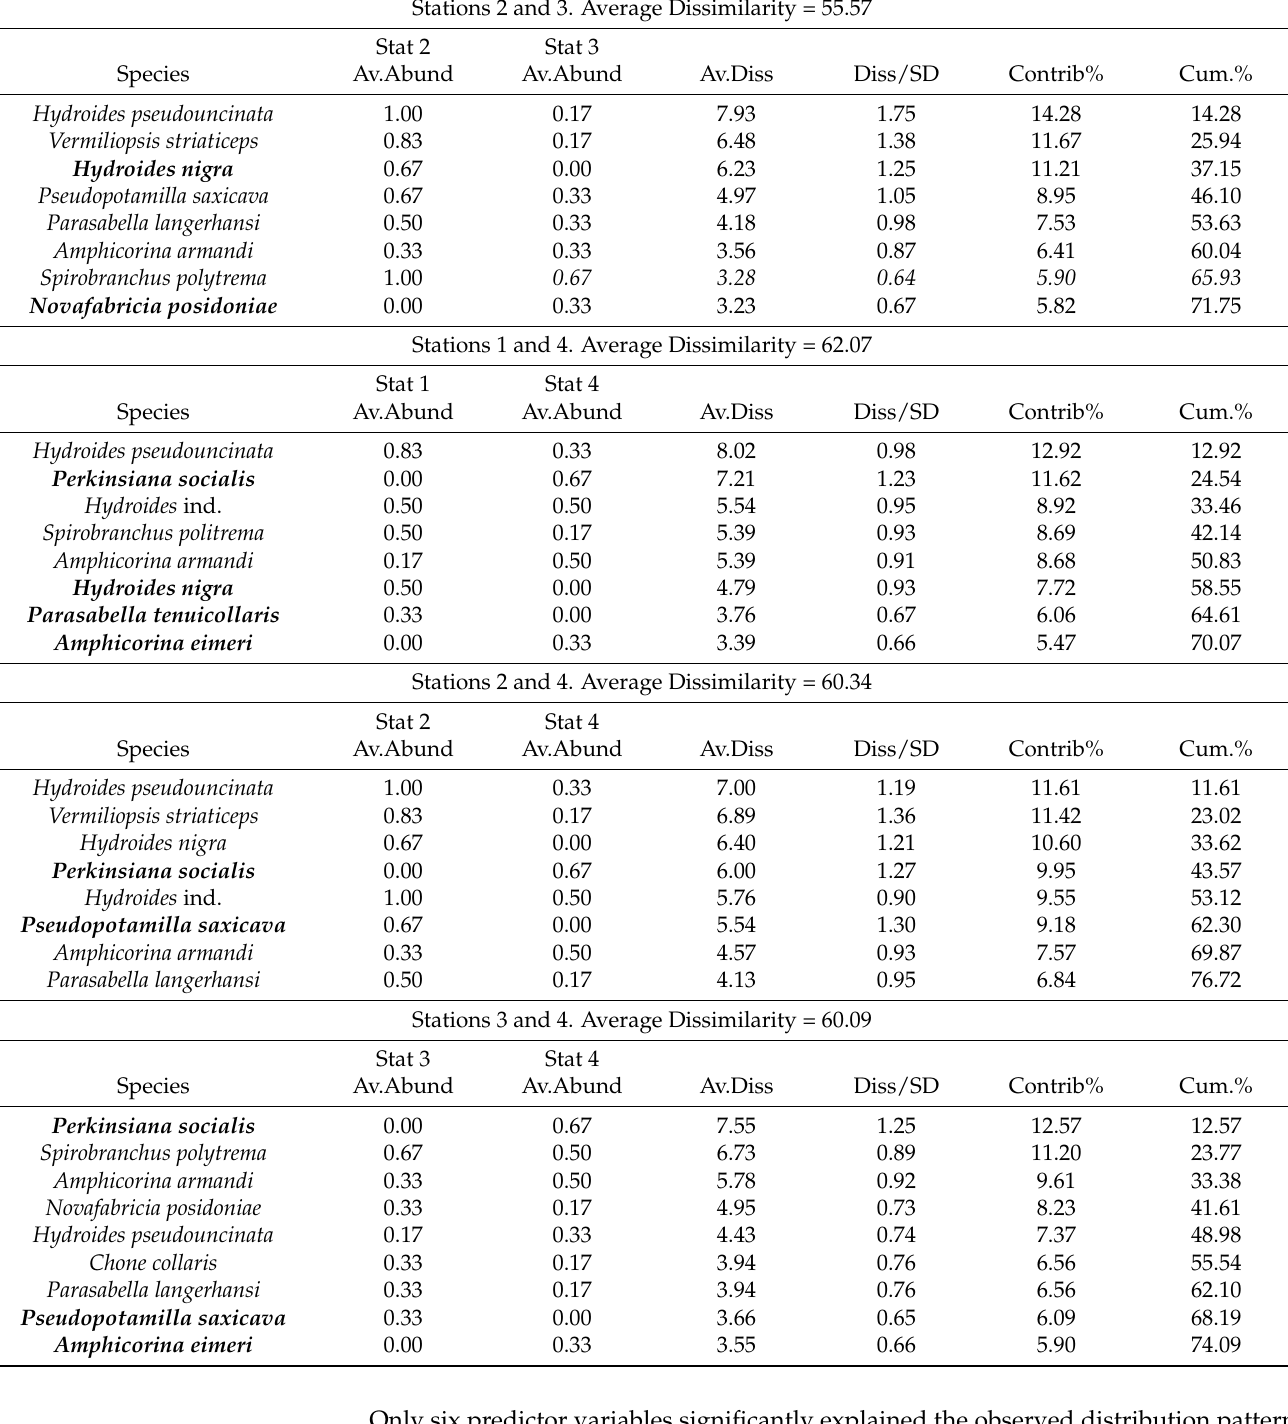
Table 4. SIMPER analysis based on species presence/absence, showing the species mostly contributing to faunal dissimilarity between stations (cut-off 70%). The species absent in one of the compared stations are given in bold. Av.Abund = average abundance, Av. Diss = average dissimilarity, Diss/SD = dissimilarity/standard deviation, Contib% = percentage contribution to dissimilarity, Cum% = cumulative percentage contribution to